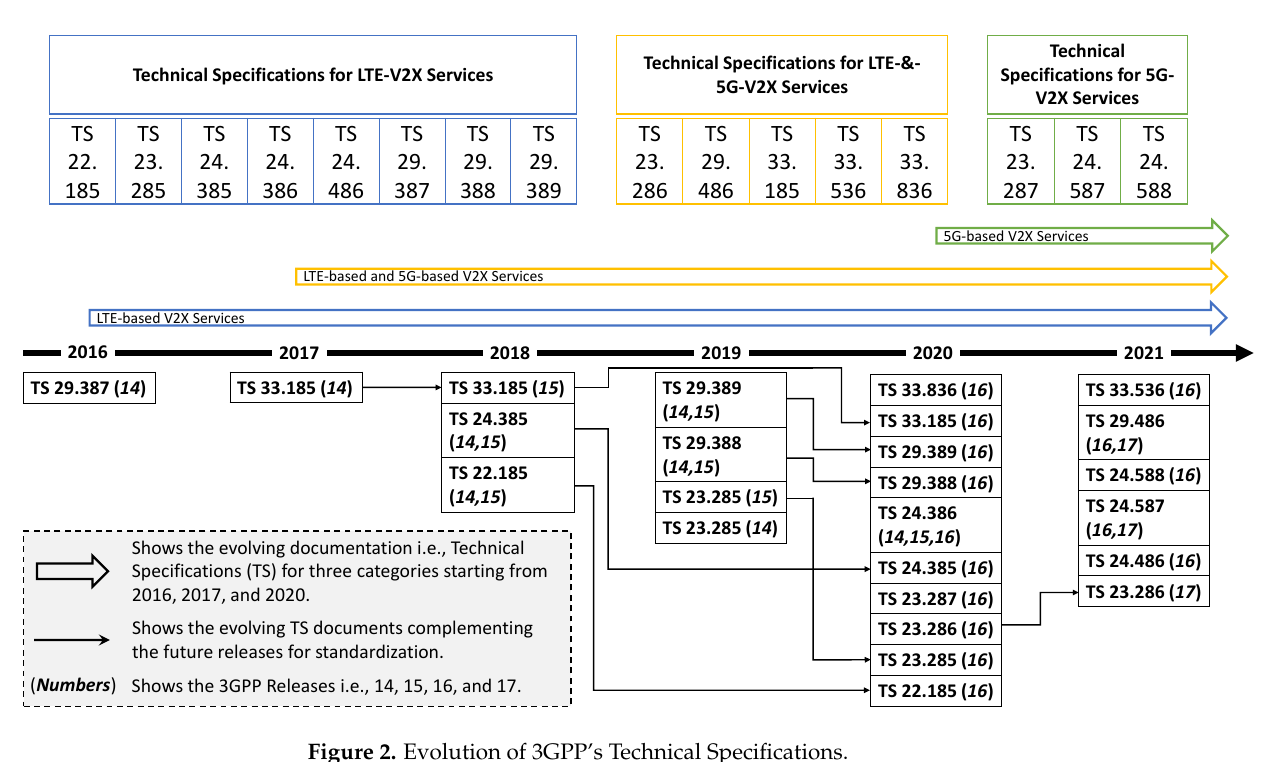
Figure 2. Evolution of 3GPP’s Technical Specifications.